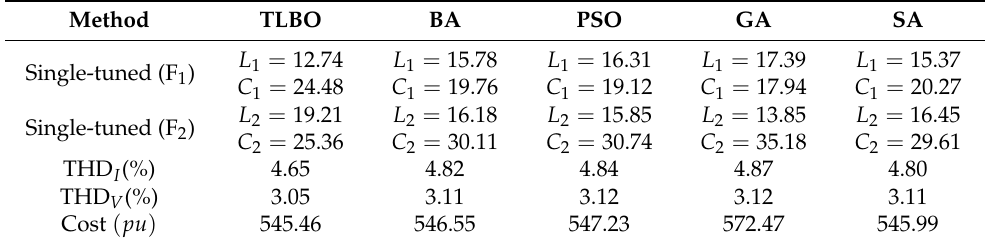
Table 7. Comparisons of PPFs design results with various methods (PF = 0.95).